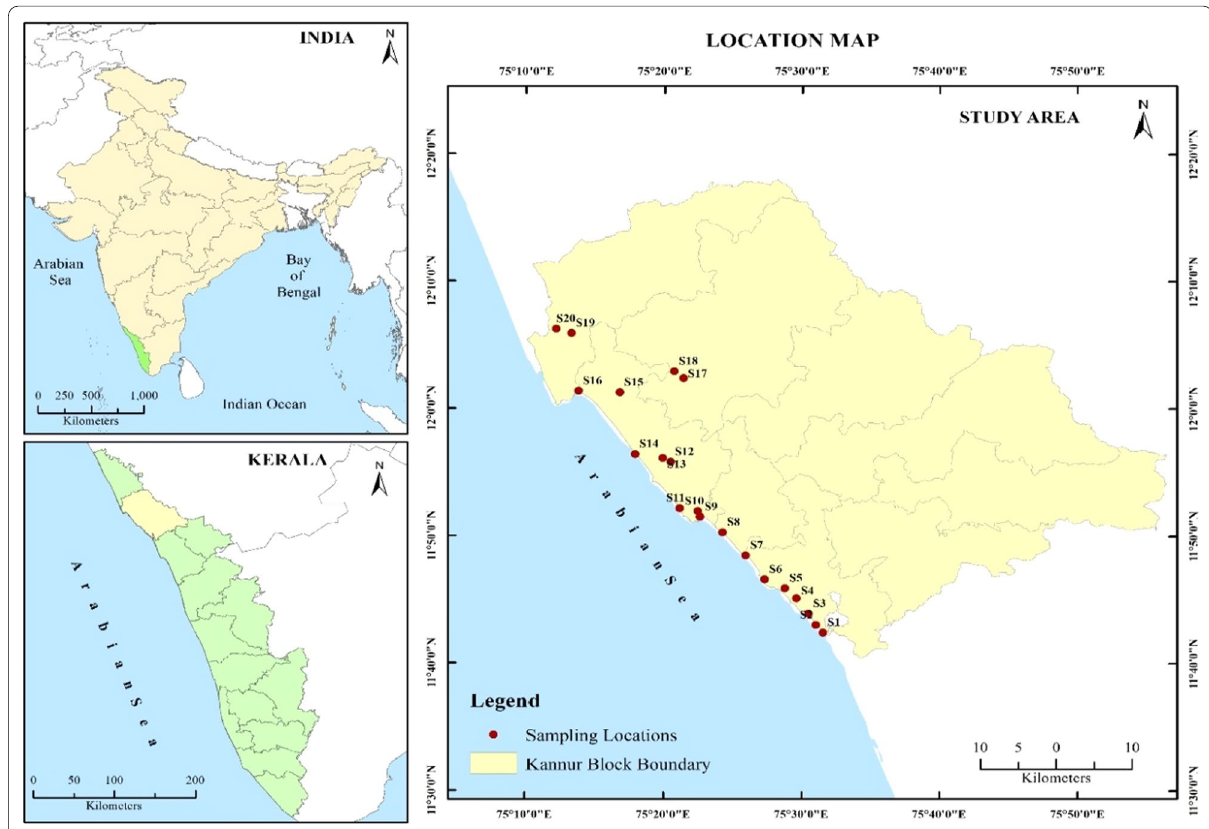
Fig. 1 Location map of the study